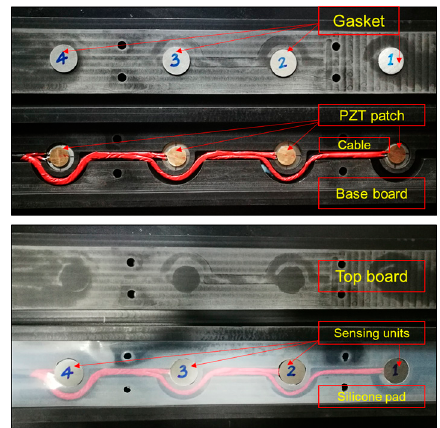
Figure 4. Internal structure of the sensing system.